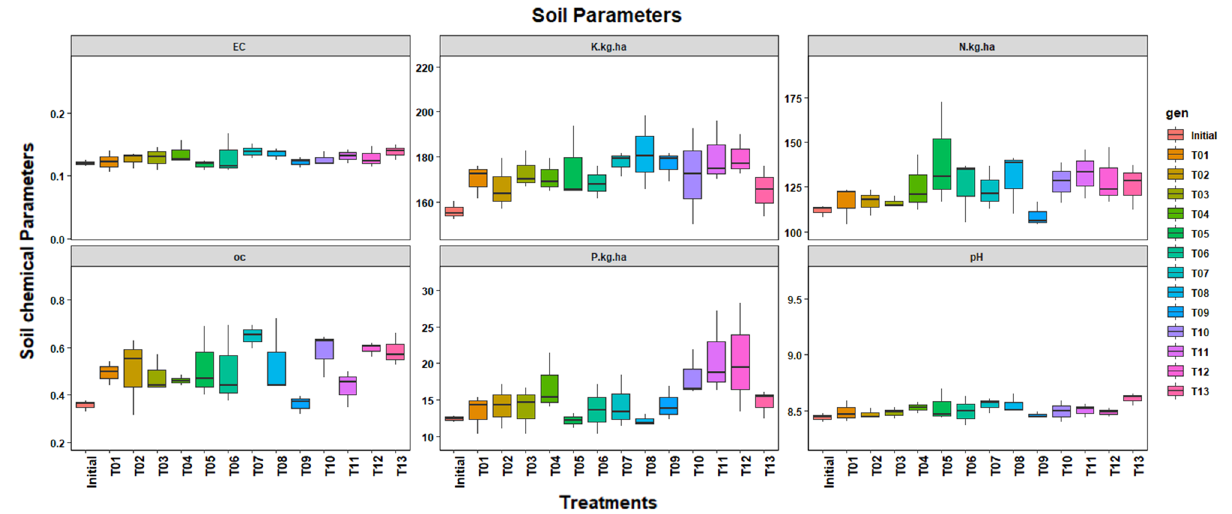
Figure 3. Effect of intercropping of legumes with maize on soil health